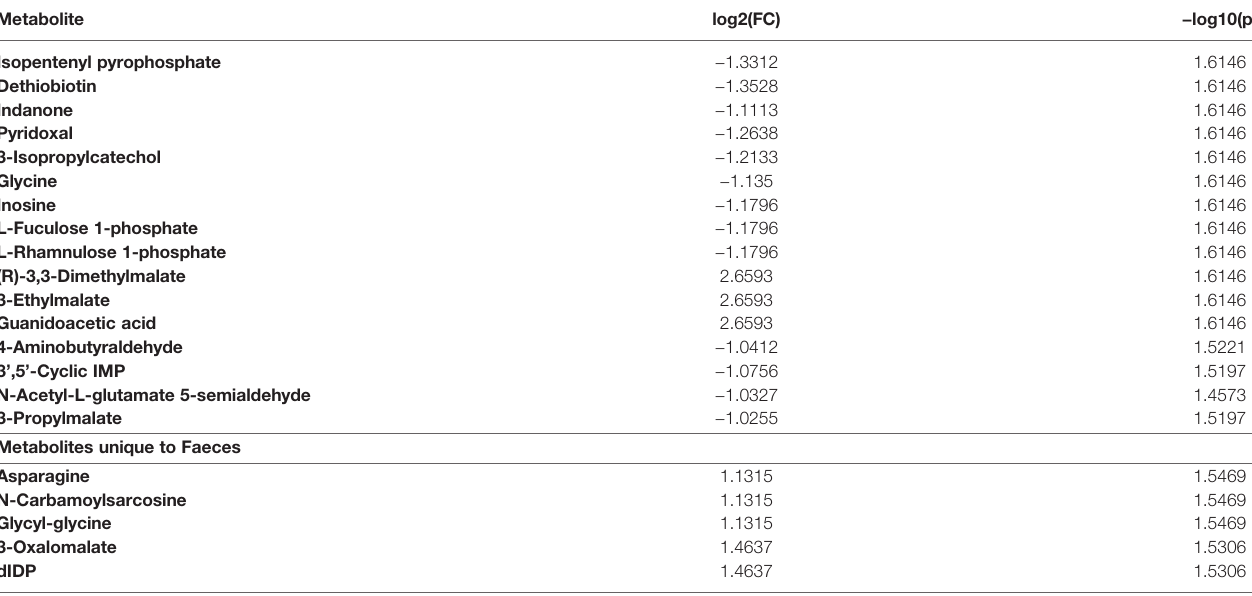
TABLE 3 | Unique metabolites identi fi ed in Urine and Feces (Control vs Infected). Metabolite log2(FC) Isopentenyl